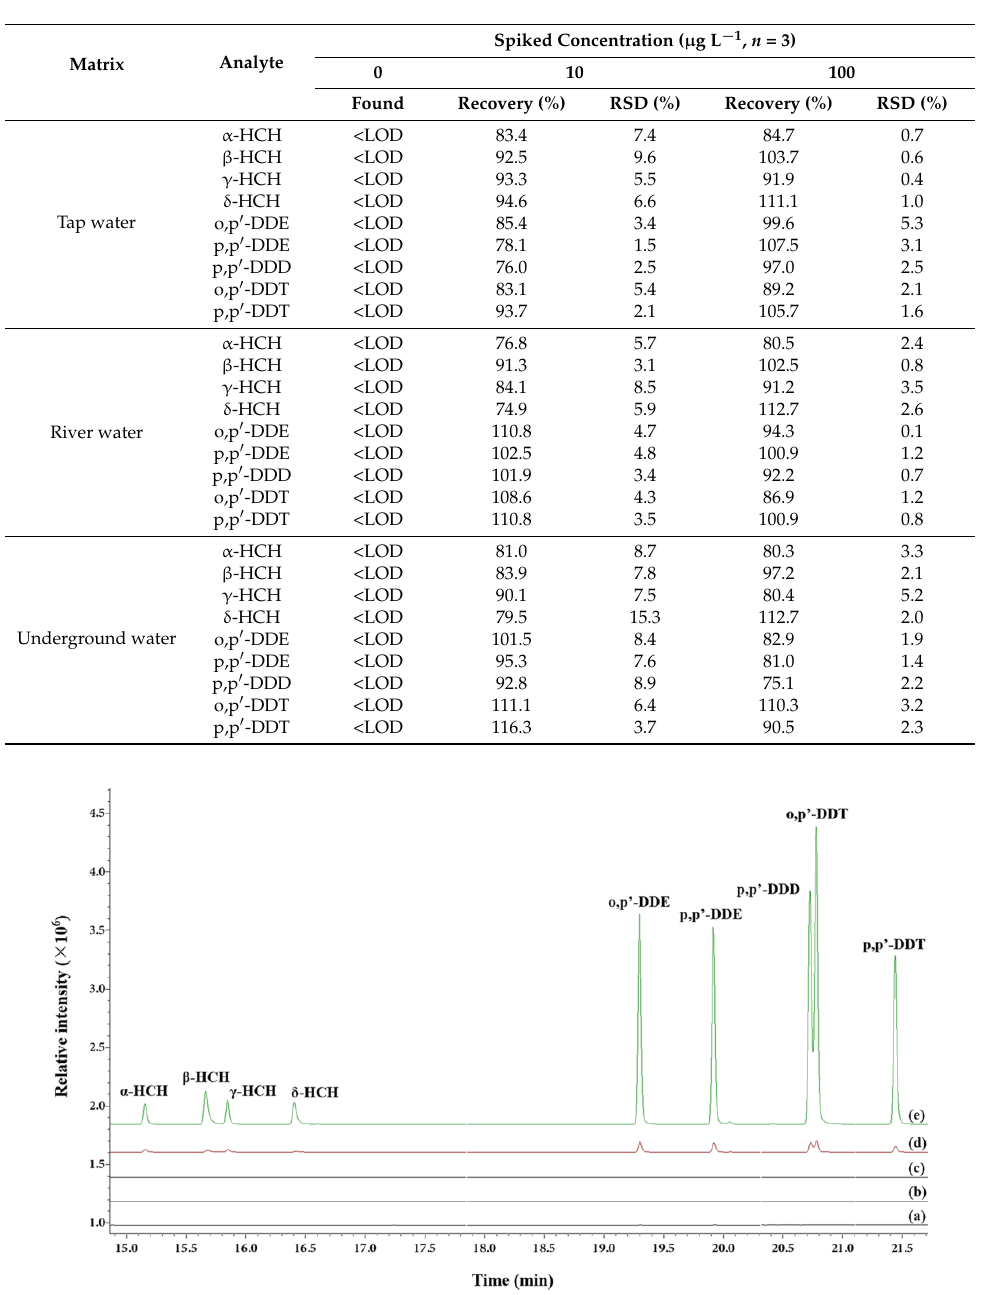
Table 4. Analytical results for determination of organochlorine pesticides in real water samples.